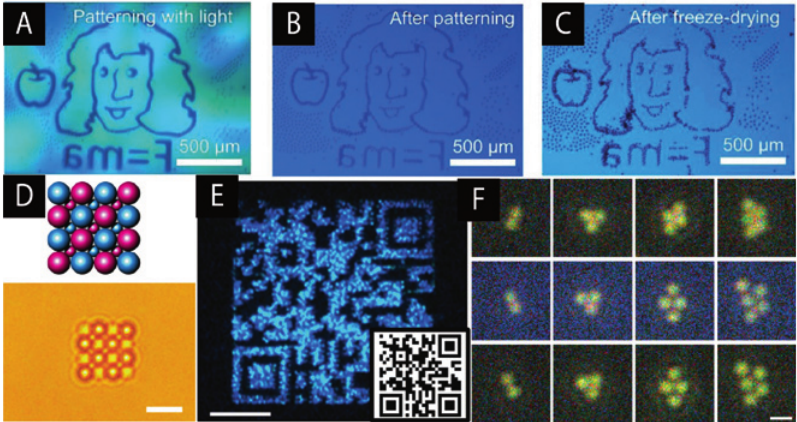
Figure 7: Examples of 2D LDA fabrication methods. (A-C) Image of Isaac